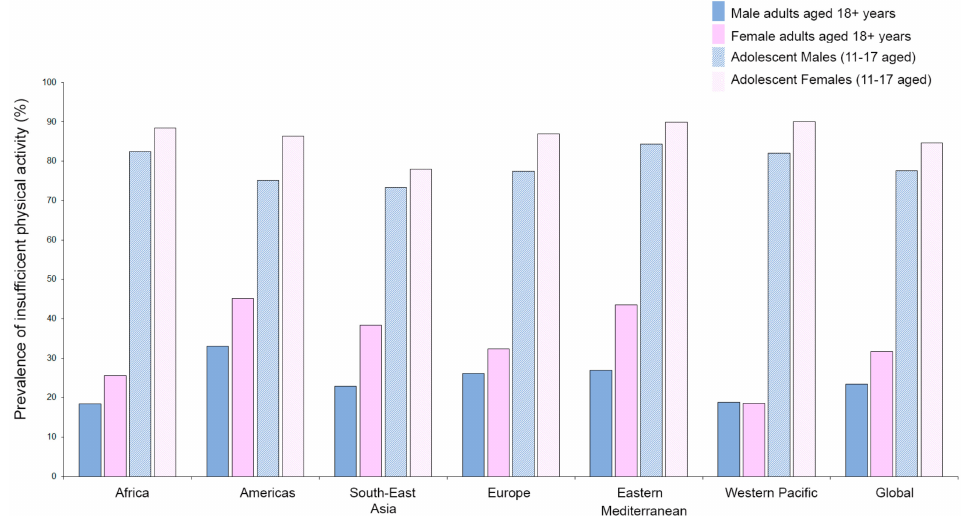
Figure 1. Prevalence of insu ffi cient physical activity as reported by WHO (https: // www.who.int / gho / ncd / risk_factors / physical_activity / en / ; data from 2016) in adults (aged 18 + years) and adolescents (11–17 years) stratified by sex and